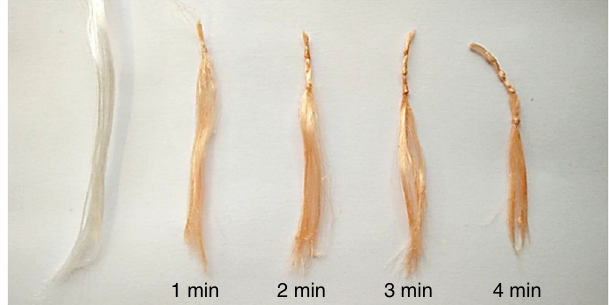
Fig. 7 Optimization of the plasma treatment time for UHMW-PE fi brous material with DR1-A. Each picture of the treated fi brous material after puri fi cation is taken compared to an untreated reference sample of the used